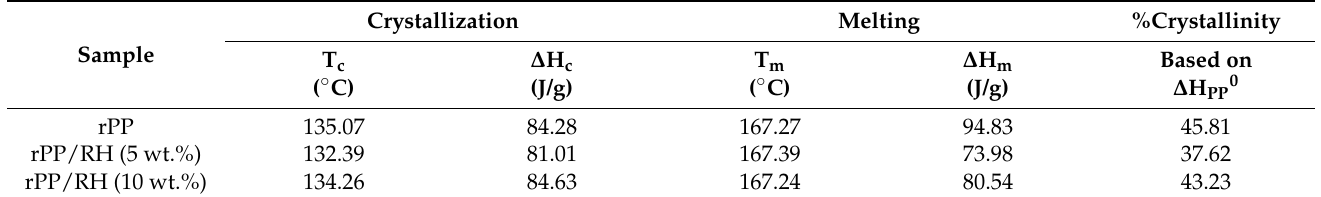
Table 2. Temperatures and enthalpies of fusion and crystallization of rPP and rPP/RH composites.